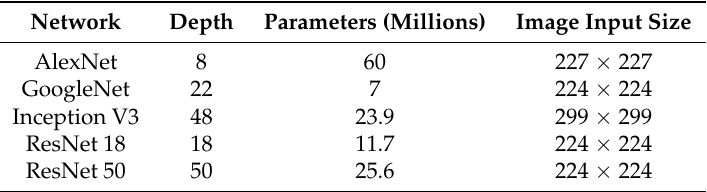
Table 3. Summary of the utilized